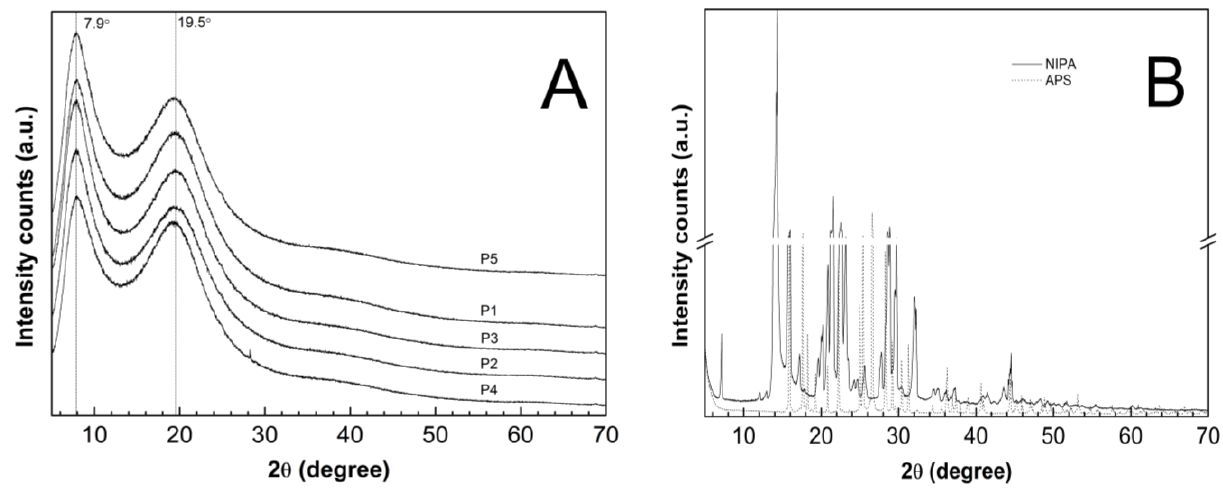
Figure 13. Powder X-Ray diffraction patterns of ( A ) synthesized co-polymers P1–P5; ( B ) monomer—NIPA; initiator—APS. Table 3. The parameters calculated from XRD data of P1–P5 co-polymer samples: peak position, intensities, and FWHM of selected diffraction peaks for the 2 θ = 5 ◦ − 70 ◦ . Sample Peak 1 2 θ ( ◦ ) Int.1 (Arbitrary